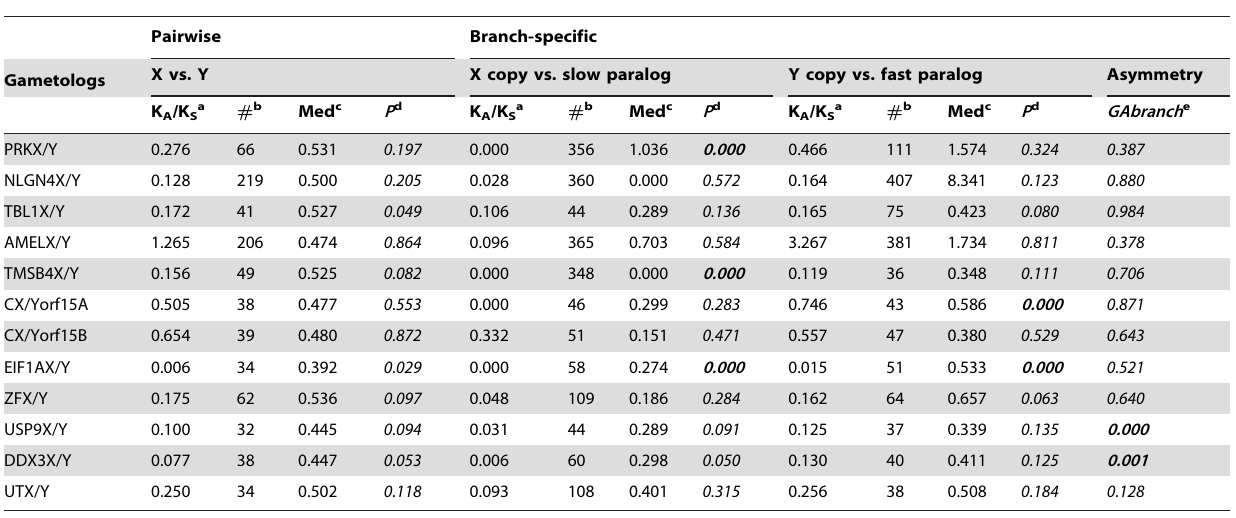
Table 1. Contrasting the evolution of gametologs and autosomal paralogs.